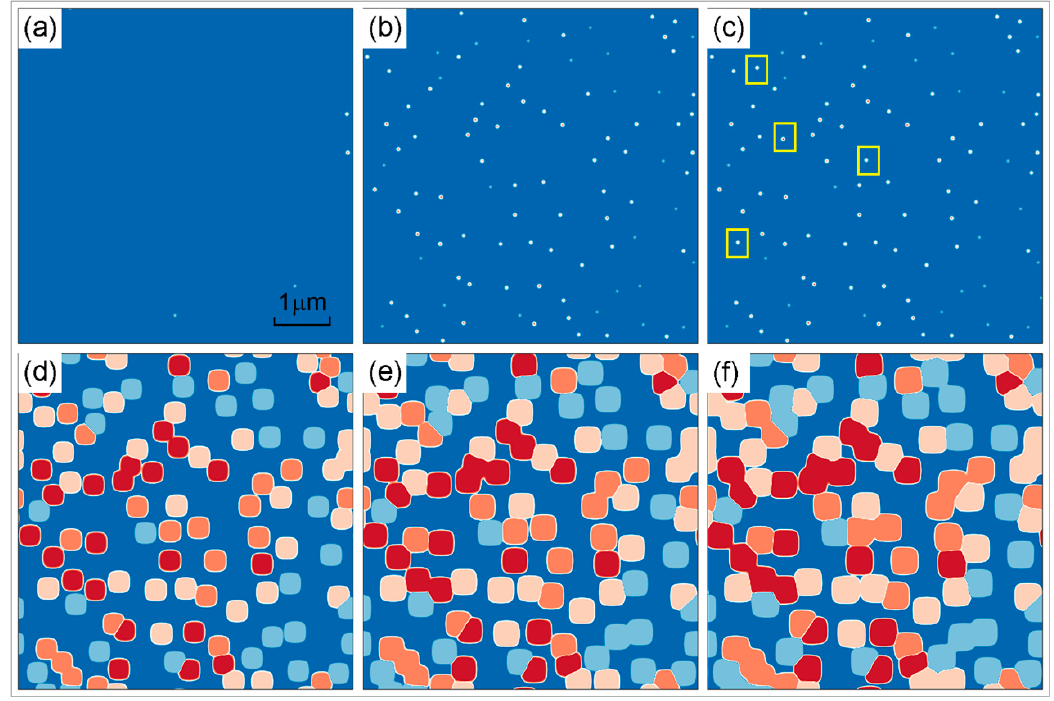
Figure 3. Simulated microstructure evolution at t = 0 ( a ), 0.006 ( b ), 0.012 ( c ), 60 ( d ), 120 ( e ) and 240 min ( f ) of DD6 superalloy under 1120 C/4 h.